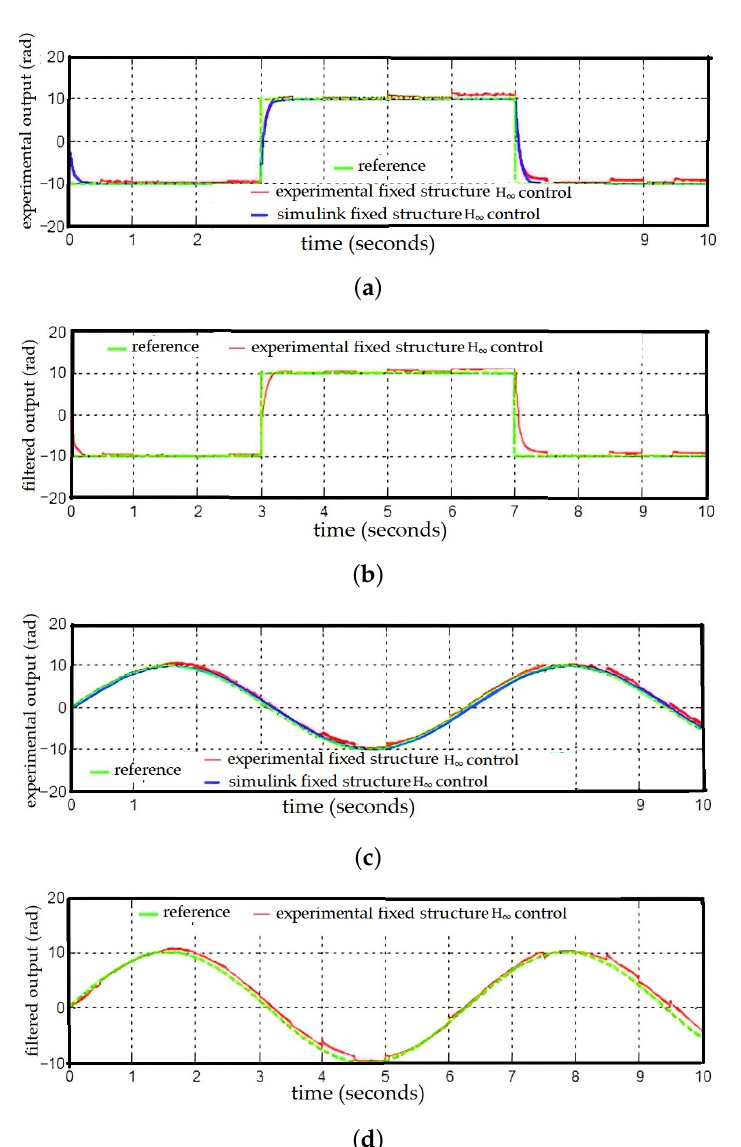
Figure 15. The experimental fixed-structure H ∞ controller for angular position tracking—square input tracking—( a , b ) and the experimental fixed-structure H ∞ controller for angular position tracking—sine input tracking ( c , d